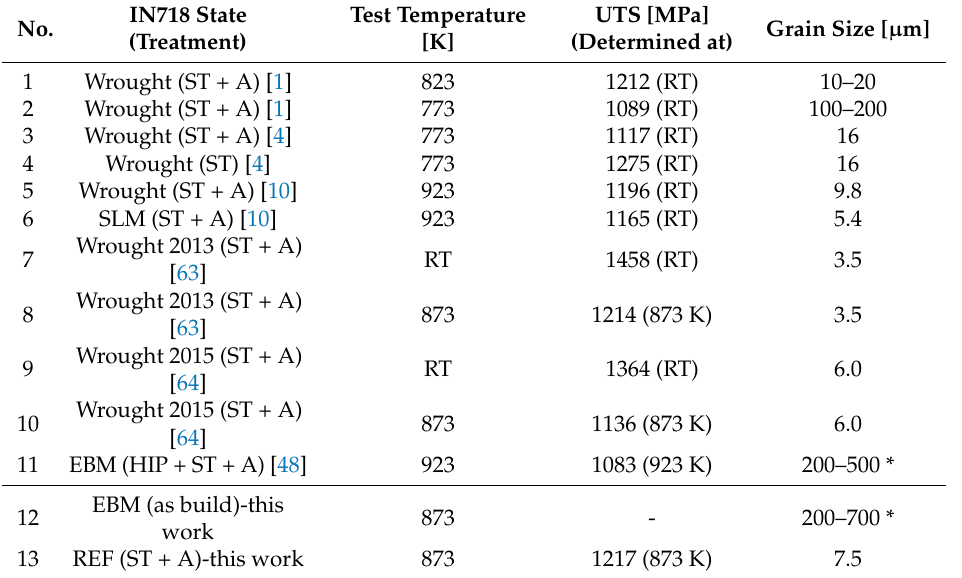
Figure 10. Comparative presentation of various SN-curves of the fatigue tests on IN718. Specified SN-curves were adopted or established by a nonlinear fit using a power function and the Levenberg– Marquardt iteration algorithm. The treatments used were solution treatment (ST), ageing (A), and hot isostatic pressing (HIP). Runouts are marked by arrows. Table 1. Summary of the material properties used for the comparative presentation of SN-curves and labelling with respect to Figure 10. Grain sizes of IN718 produced by selective electron beam melting marked by (*) are given as a range of widths perpendicular to the load axis. Further values of the grain sizes are given according to the corresponding reference (see 2nd column). Treatments used were solution treatment (ST), ageing (A), and hot isostatic pressing